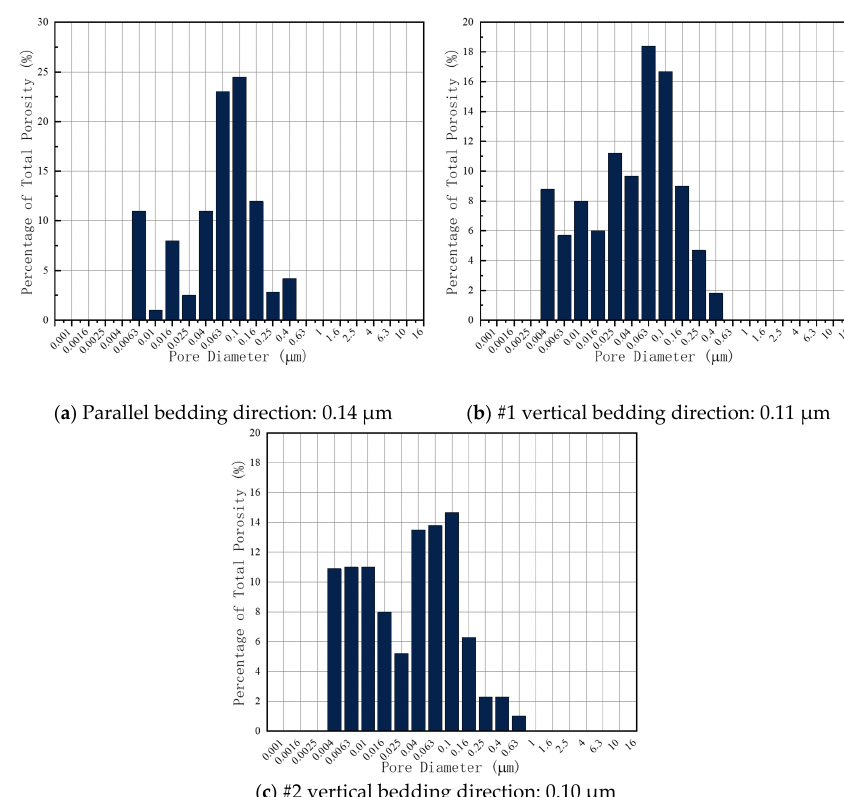
Figure 7. Average pore diameter in different directions of CZ-Y47-1.